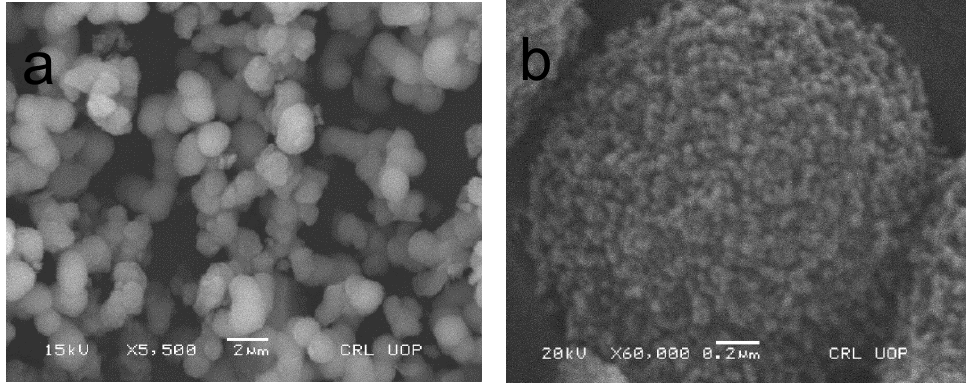
Figure 2. SEM image of silica monolith particles: ( a ) before BR5 adsorption; ( b ) after BR5 adsorp- tion.